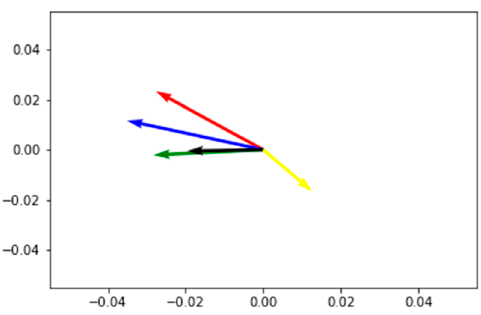
Figure 5. Representation of a 2D embedding space with five embedding vectors each representing a different word [38]: Red—queen, blue—king, green—man, black—woman and yellow—oil.